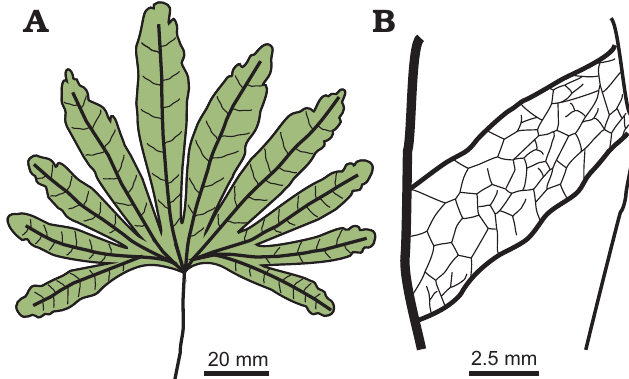
Fig. 5. Dipterid fern Dictyophyllum menendezi sp. nov. from Cortaderita Formation (Ladinian, Middle Triassic) of Barreal-Calingasta, San Juan Province, Argentina. A . Diagramatic reconstruction of the leaf. B . Sketch drawing of pinnae